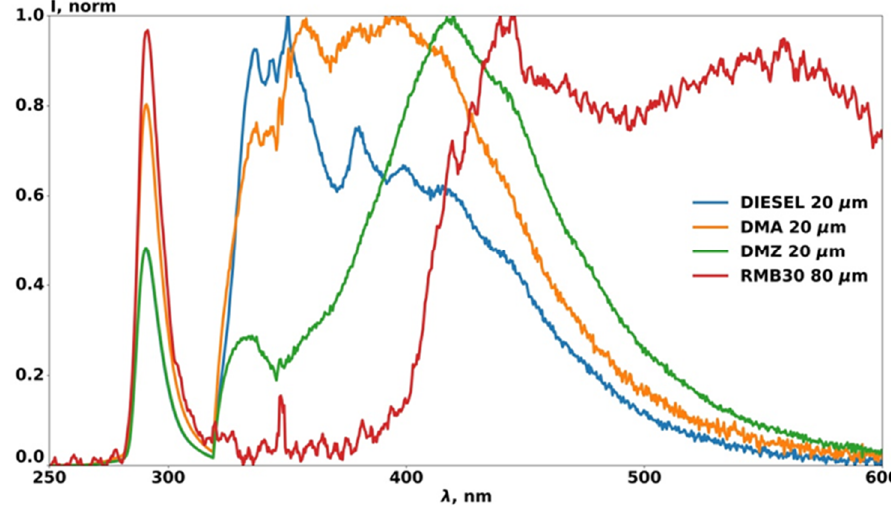
Figure 13. LIF slick spectra of the different types of oil products.